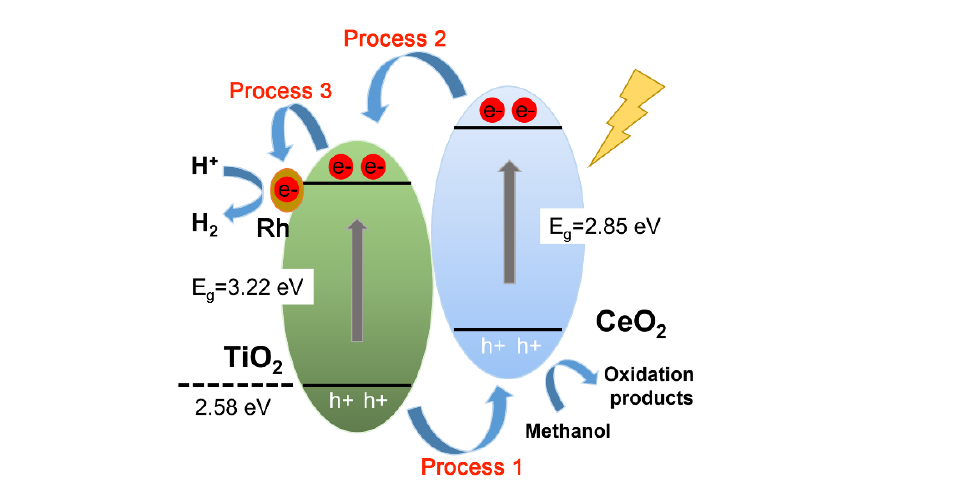
Figure 6. The schematic diagram of photocatalytic hydrogen production over Rh–TiO 2 –CeO 2 hybrid photocatalysts under irradiation.